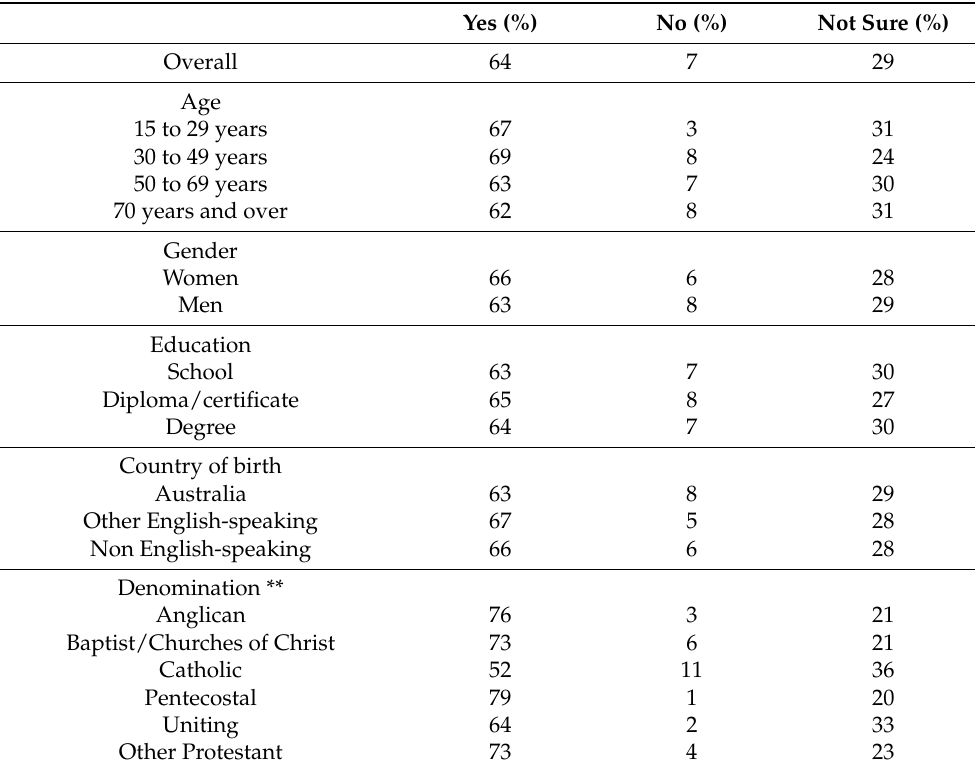
Table 11. Churchgoer views about approaching the church for